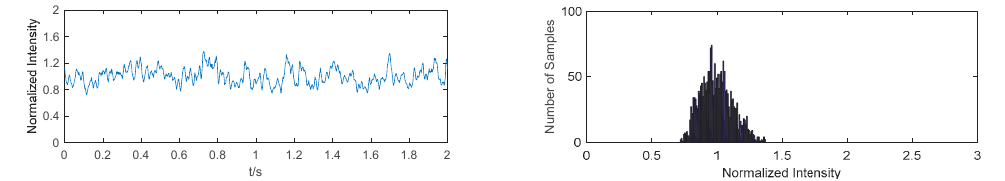
Figure 7. The curve and histogram of the channel gain collected by 1.2 m telescope.